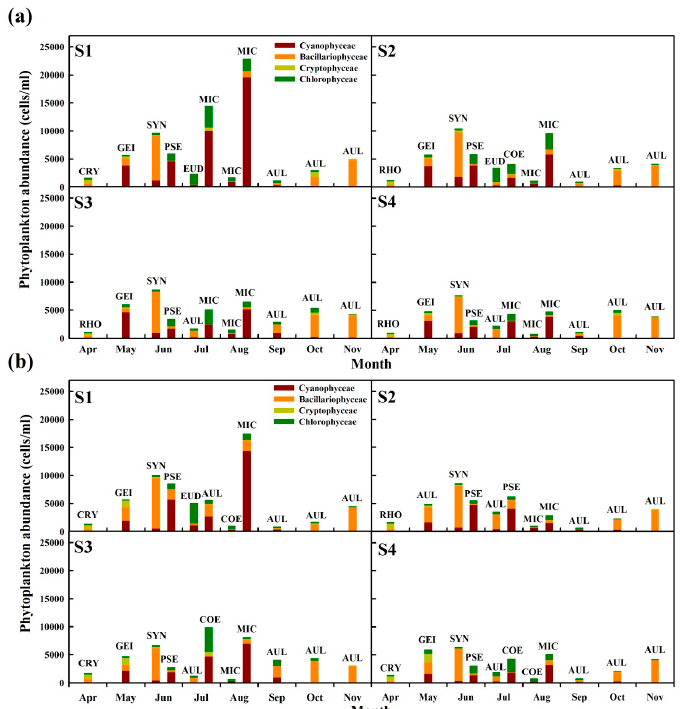
Figure 2. Populations of algae at each monitoring point in the Jinyang Reservoir: ( a ) upper layer, ( b ) middle layer. Dominant species are marked on each bar graph. (CRY: Cryptomonas, GEI: Geitlerinema , SYN: Synedra , PSE: Pseudanabaena , EUD: Eudorina , MIC: Microcystis , AUL: Aulacoseira , RHO: Rhodomonas , COE: Coelastrum ).